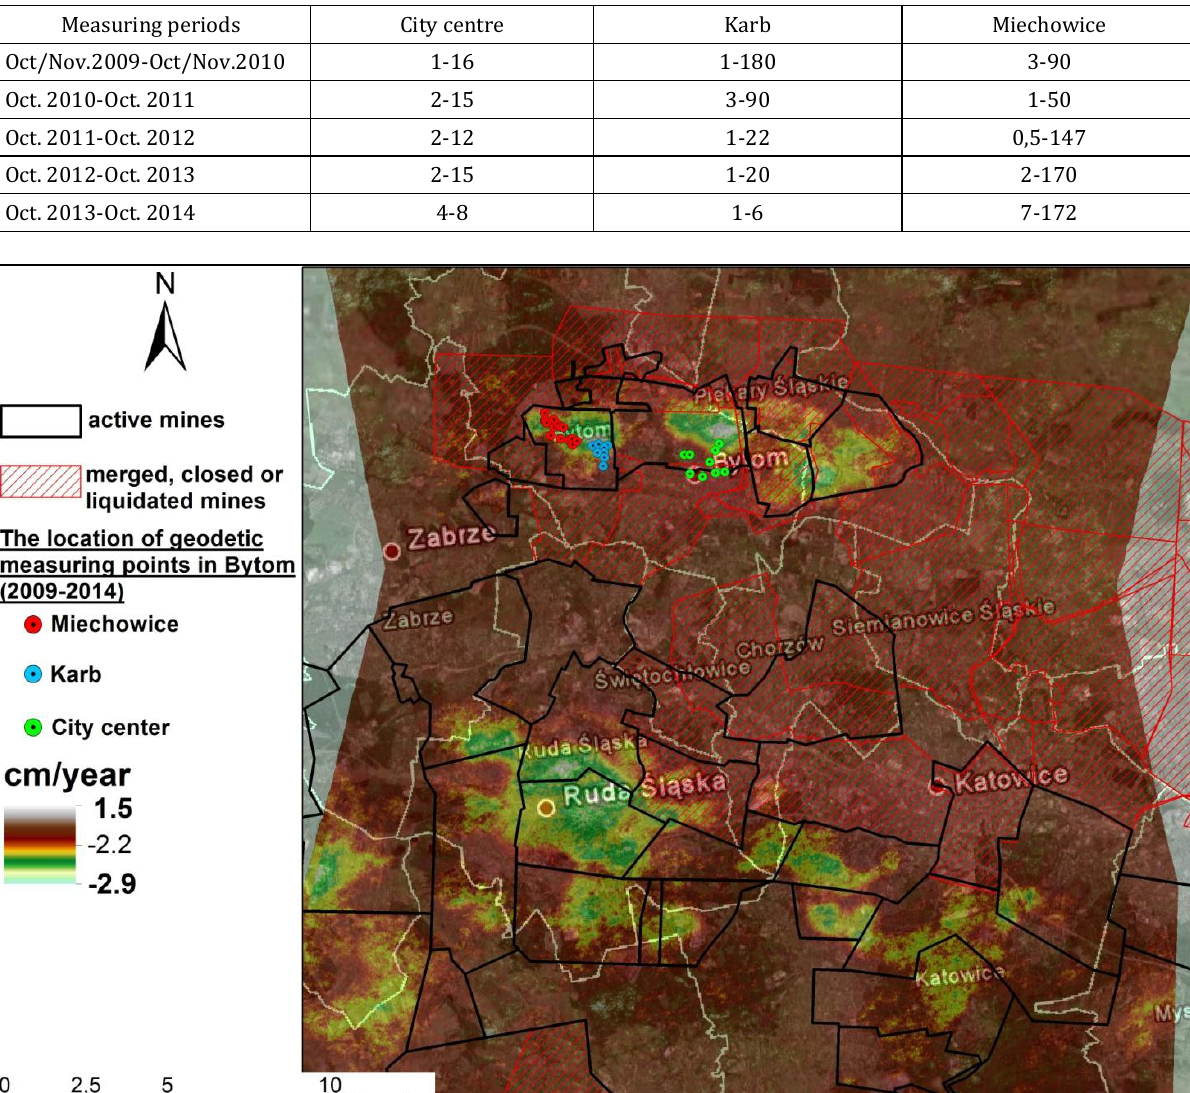
Table 2. Geodetic information related to subsidence in different districts of Bytom (values in cms). Data source: Yearly reports on the state of Bytom city 2010-2014. (Skrzypczyk-Kogut, 2011, 2012; Domagała, 2013, 2014)